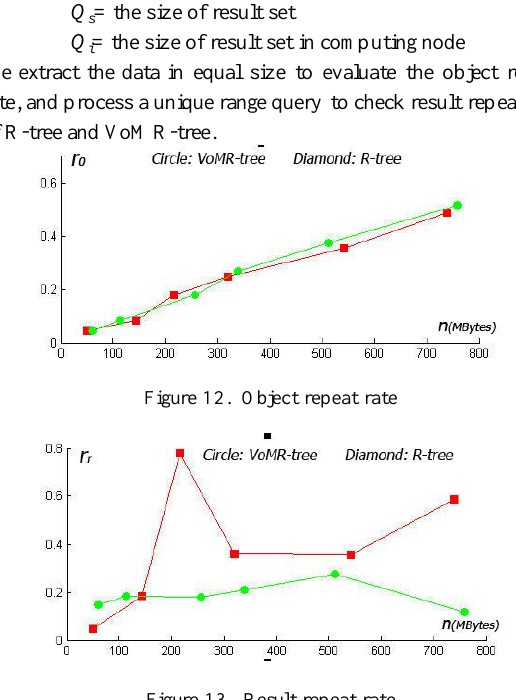
Figure 13. Result repeat rate